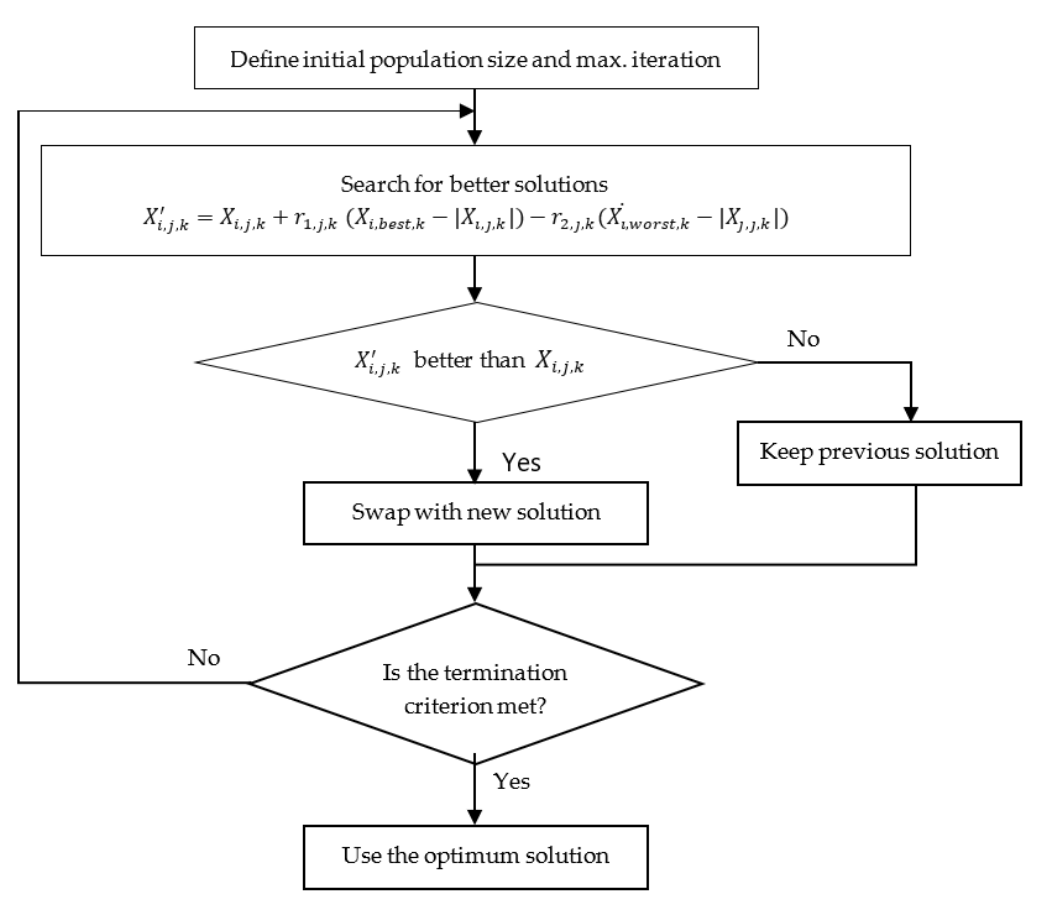
Figure 4. Jaya algorithm.